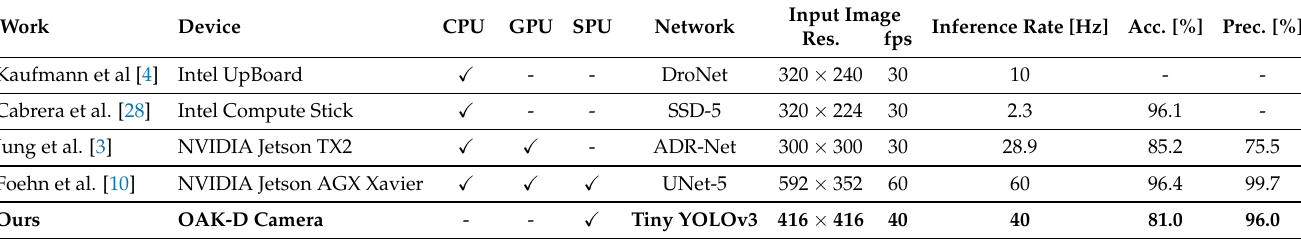
Table 2. A comparison of works using artificial neural networks for gate detection in the context of ADR. Devices responsible for running the network, mentioning whether it has a CPU, GPU, or a specialised processing unit (SPU), are indicated. For example, NVIDIA Jetson Xavier has two SPUs, and a vision and a deep learning accelerator, and the OAK-D camera has only one SPU, an Intel Movidius Myriad